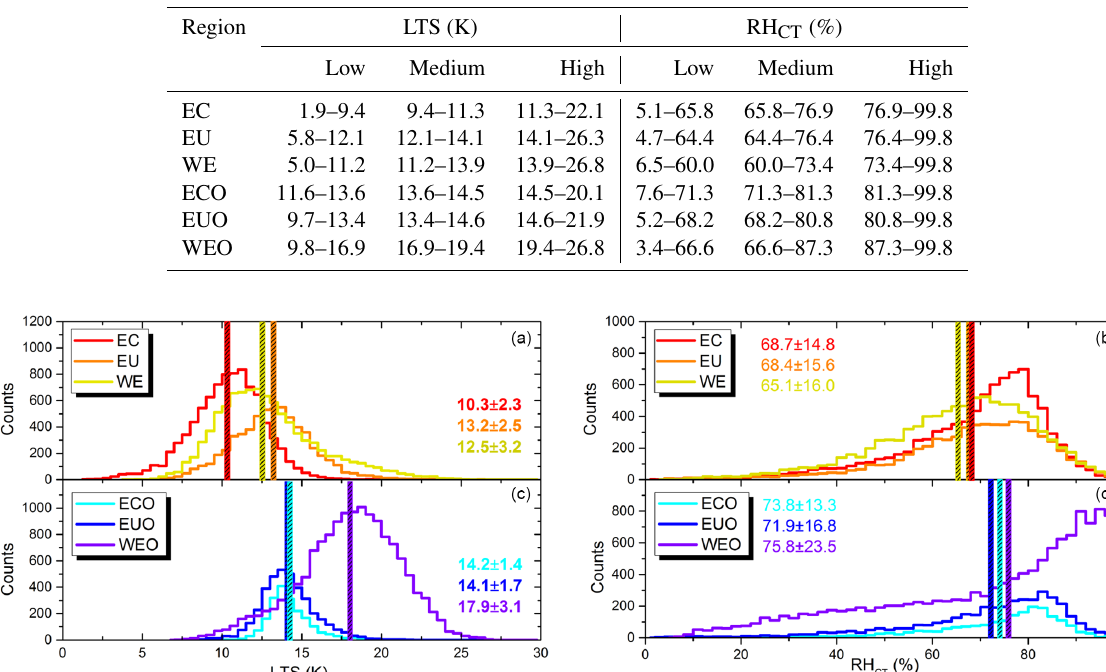
Table 2. The range of LTS and RH CT for low, medium, and high conditions.